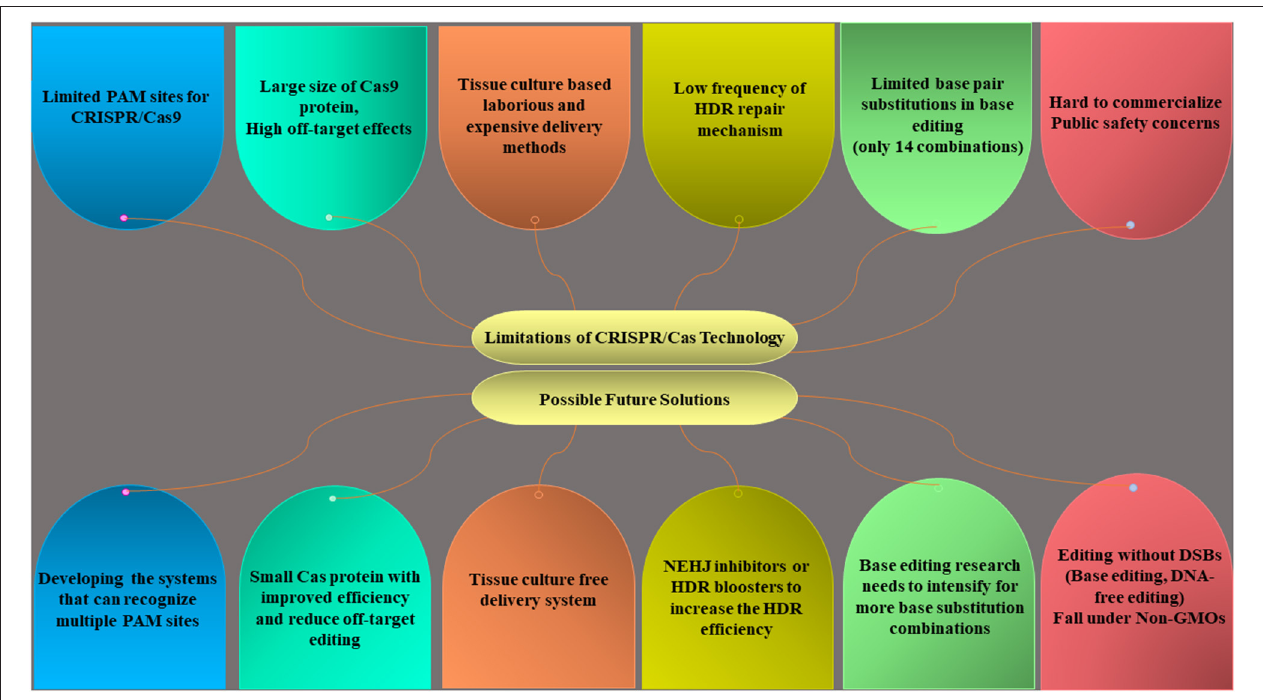
FIGURE 6 | Limitations of the CRISPR/Cas system and a future way forward to develop ideal editing